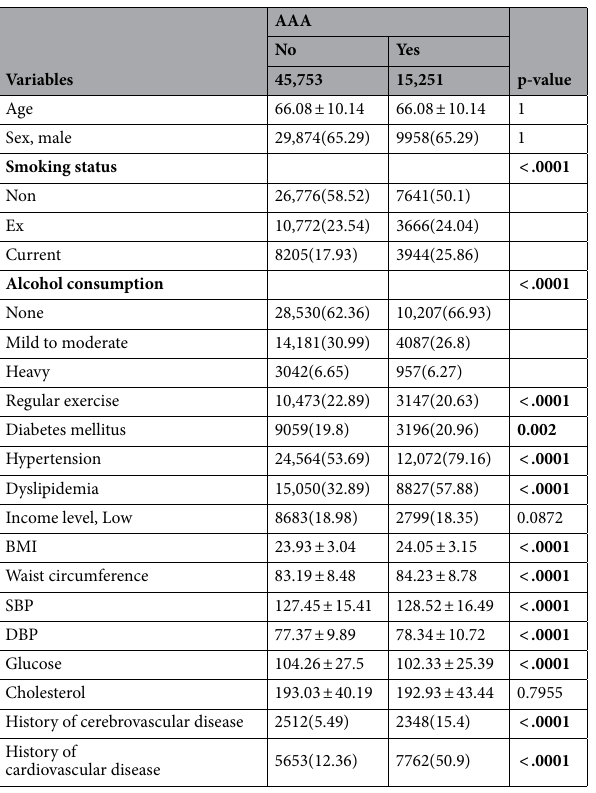
Table 1. Clinical characteristics of control and abdominal aortic aneurysm (AAA) patients. BMI Body mass index, SBP Systolic blood pressure, DBP Diastolic blood pressure.